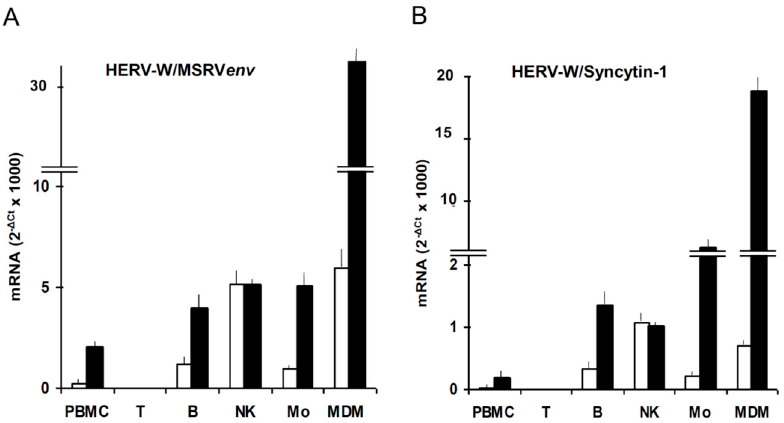
Figure 3. Expression of HERV-W/MSRVenv and HERV-W/Syncytin-1 mRNAs by PBMC subsets, as such and after exposure to the EBVgp350 protein. PBMC from HERV-W/MSRV(+) donors were tested as such, and after immunobeads separation in CD3+T, CD19+ B, CD56+/CD192/CD32 NK and CD192/CD3–/CD562 monocyte subsets; monocyte aliquots were also differentiated into macrophages (MDM). The cells were treated overnight with recombinant EBVgp350 protein, then were harvested and processed for mRNA extraction, reverse transcription and real time PCR with primers selective for HERV-W/MSRVenv and HERV-W/Syncytin-1, as published [43]. ( A ) HERV-W/MSRVenv. ( B ) HERV-W/Syncytin-1. Open bars: basal levels; black bars: mRNA levels of cells exposed in vitro to EBVgp350.